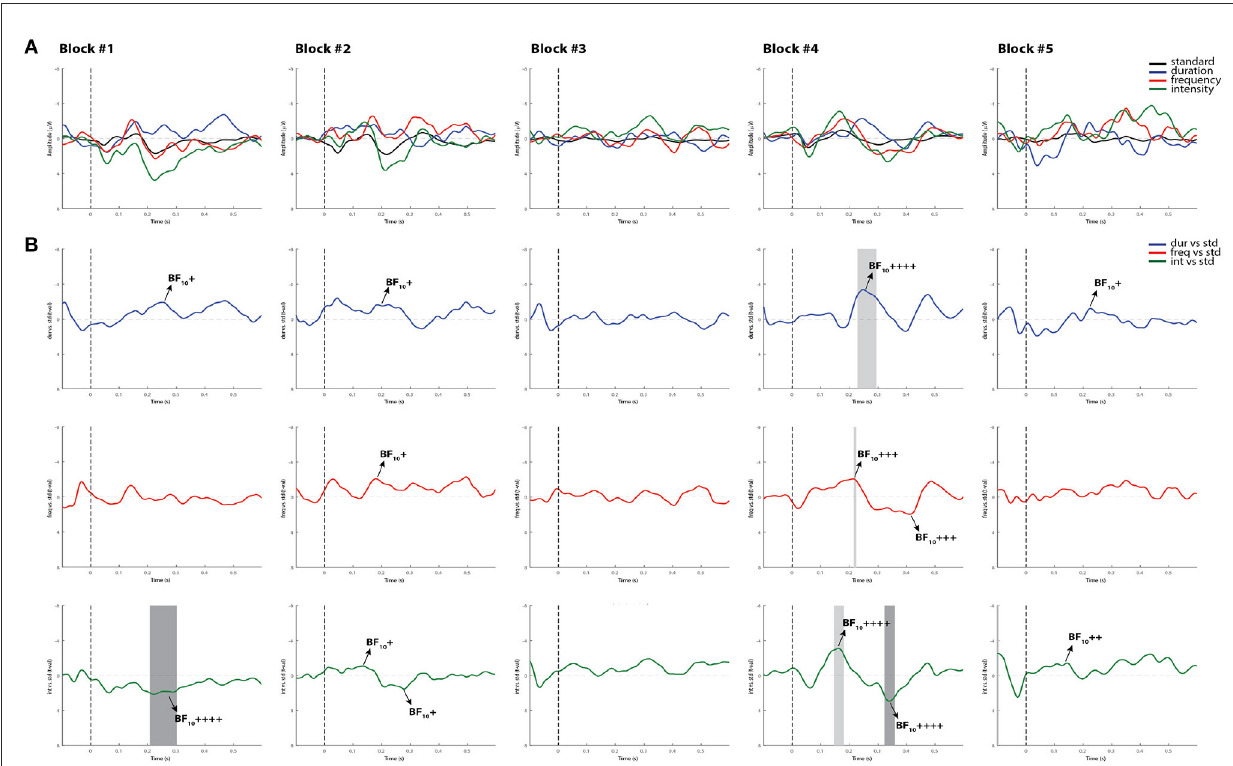
FIGURE6 Individual ERPs and statistical findings of a coma patient (Patient 1) in the first five blocks on day 0. (A) Individual ERPs across blocks. (B) Time course of the difference between deviants and standard stimuli expressed in units of t -values. Significant intervals for negative components are denoted by a light gray area, and those for positive components are denoted by a dark gray area. Black arrows show the latency of maximum Bayes factors and the strength of evidence for H 1: +, anecdotal; ++, moderate; +++, strong; ++++, very strong to